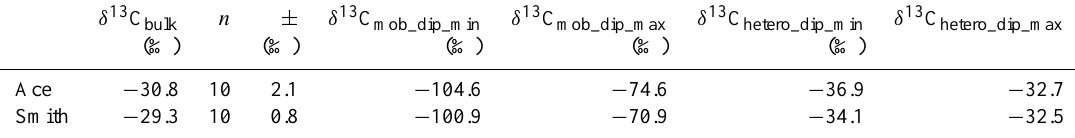
Table 1. Mixing model end-member values and δ 13 C values of the primary variables used to calculate the proportion of MOB at each sample point. δ 13 C bulk is the average bulk sediment value from each lake; ± indicates the standard deviation of the δ 13 C bulk . MOB and heterotrophic bacteria have been assumed to have maximum levels of lipid biosynthesis occurring (10 and 4‰ respectively). δ 13 C mob_dip_min is the estimated minimum stable isotope value given the δ 13 C value of methane at each lake and the maximum potential fractionation of carbon by MOB. δ 13 C mob_dip_max is the estimated value of MOB with no fractionation during assimilation. δ 13 C hetero_dip_max is the maximum estimated stable isotope value of heterotrophic bacteria if no fractionation is occurring during assimilation and the bulk sediment is + 1.0 standard deviation (SD) from the mean at each lake. δ 13 C hetero-hopane_min represents the minimum value for heterotrophic hopanes given maximum possible fractionation during assimilation and if bulk sediment is − 1.0 SD from the mean. δ 13 C